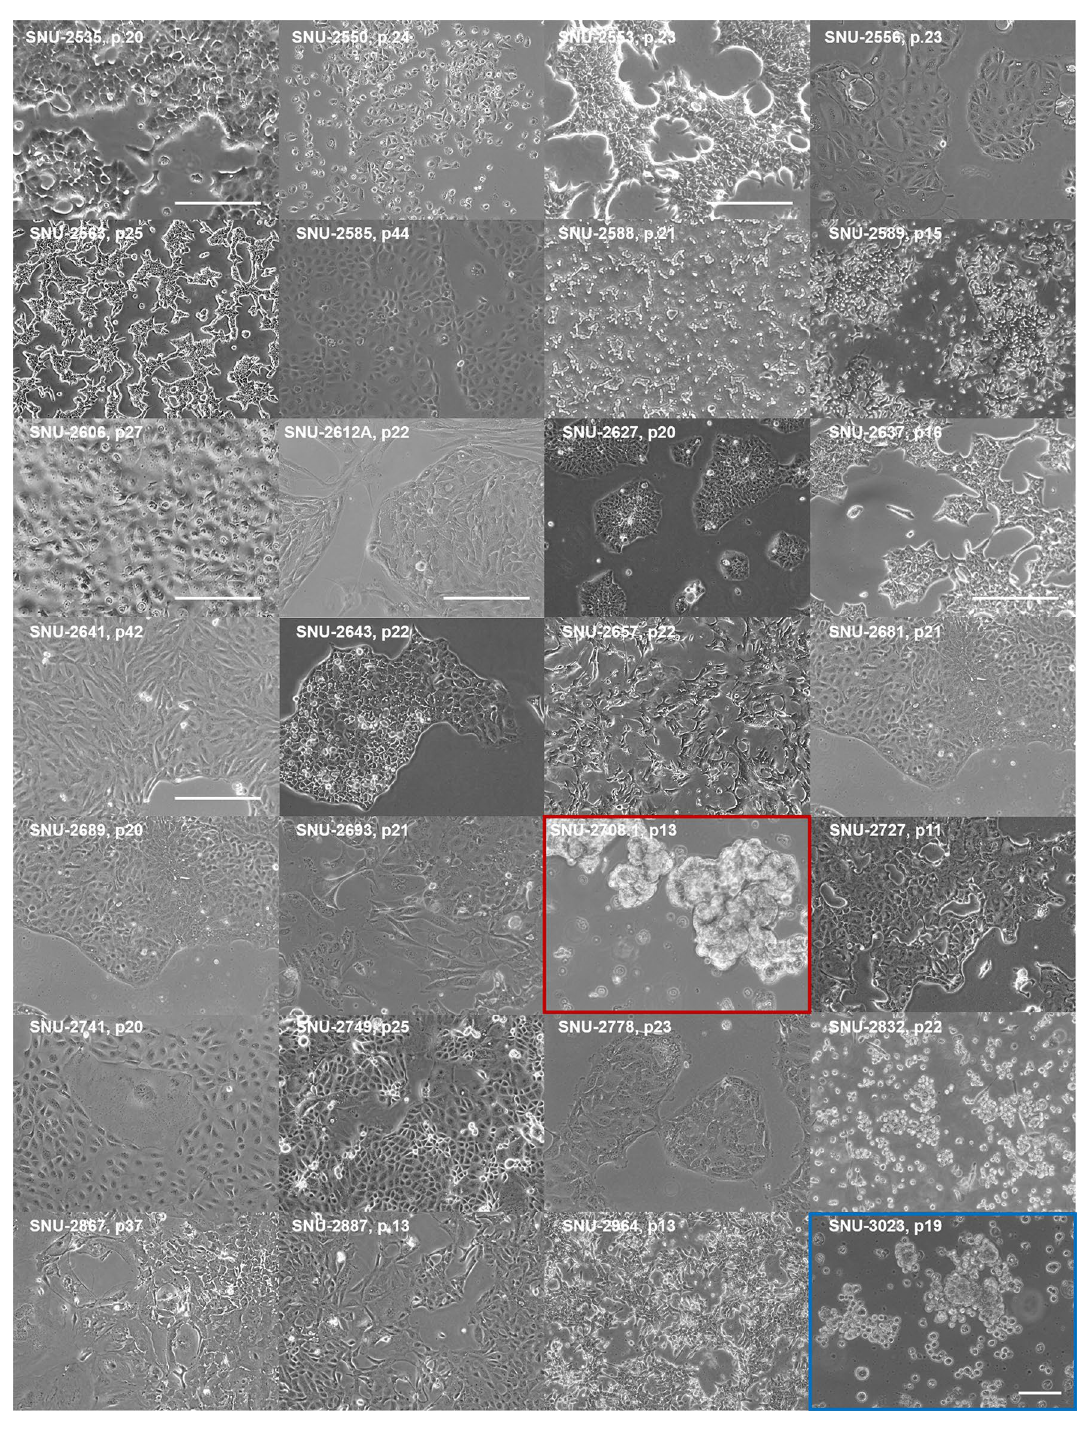
Figure 1. The morphologies of MPE-derived human lung adenocarcinoma cell lines exhibited heterogeneous growth patterns. Most cell lines grow as adherent form, suggesting cells floating in the pleural cavity maintained the capability to adhere. Various growth patterns include polygonal ( n = 14), fibroblast-like ( n = 3), round ( n = 2), oval ( n = 5) and mixed ( n = 4) form. Scale bar = 100 Transcriptomic analysis of MPE‑derived lung cancer cell lines reveal a separation of EGFR and fusion types. We then verified that the pattern of mRNA expression reflects the distinctive genomic aber- rations. The principle component analysis (PCA) of the mRNA expression indicated that MPE-derived cell lines were likely grouped in accordance with their genetic factors (Fig. 3A). Cell lines with EGFR mutation were specifically clustered with less degree of dispersion on the PCA plot compared to the fusion group, which sug- gests that EGFR -mutated NSCLCs in MPE display characteristic transcription patterns. Hierarchical clustering